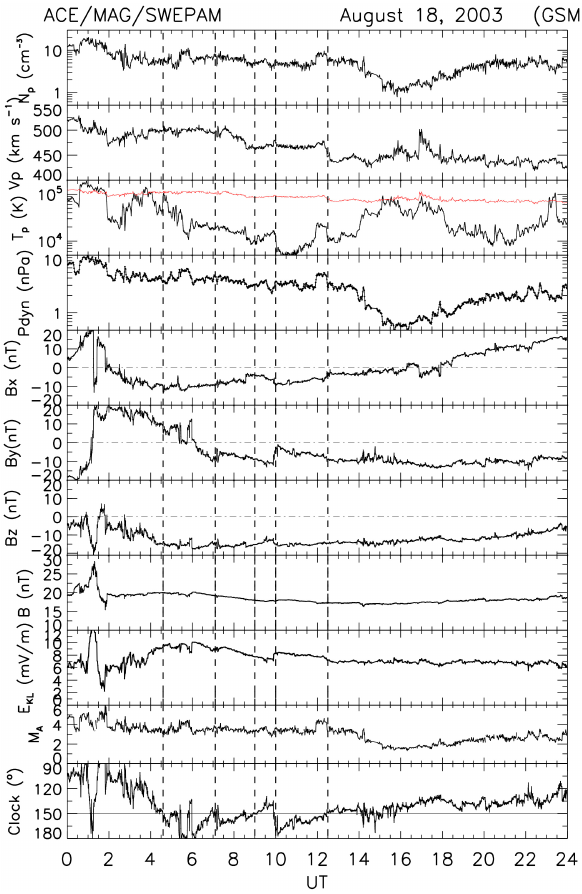
Fig. 2. Interplanetary data from spacecraft Advanced Composition Explorer (ACE). Panels from top to bottom show proton density ( N p ; cm − 3 ); bulk speed ( V p ; kms − 1 ); proton temperature T p (K; in red the expected temperature after Lopez and Freeman, 1986); dynamic pressure P dyn (nPa); magnetic field components B x , B y and B z in GSM coordinates; the field strength B (nT); the Kan–Lee merging electric field E KL (mVm − 1 ); the Alfvén Mach number M A ; and the clock angle of the magnetic field ( ◦ ). Different field orientations (clock angle regimes) are marked by vertical dashed